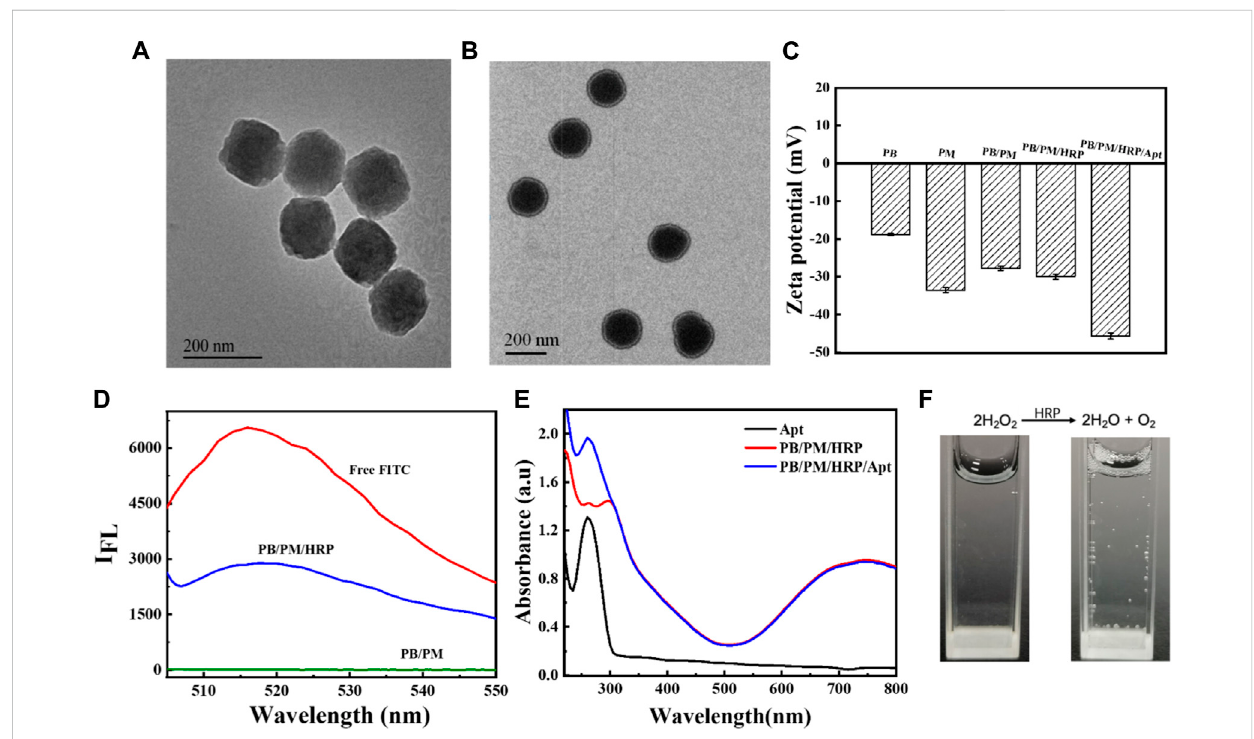
Synthesis and characterization of PB/PM/HRP/Apt. (A) TEM image of PB. (B) TEM image of PB/PM. (C) Zeta potential changes of PB, PM, PB/PM, PB/ PM/HRP,PB/PM/HRP/Apt. (D) FluorescencespectraoffreeFITC,PB/PM/HRPandPB/PM. (E) UV-VisabsorptionspectraofApt,PB/PMandPB/PM/Apt. (F) Reaction cup evolution of bubbles in hydrogen peroxide solution, add PB/PM/Apt reagent on the left and PB/PM/HRP/Apt reagent on the